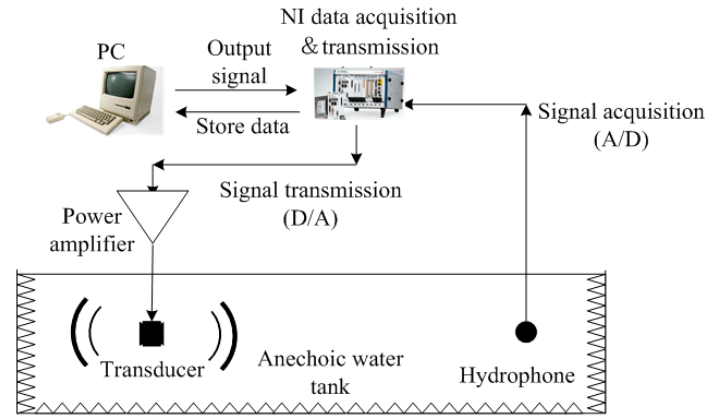
Figure 4. The diagram of the experiment.